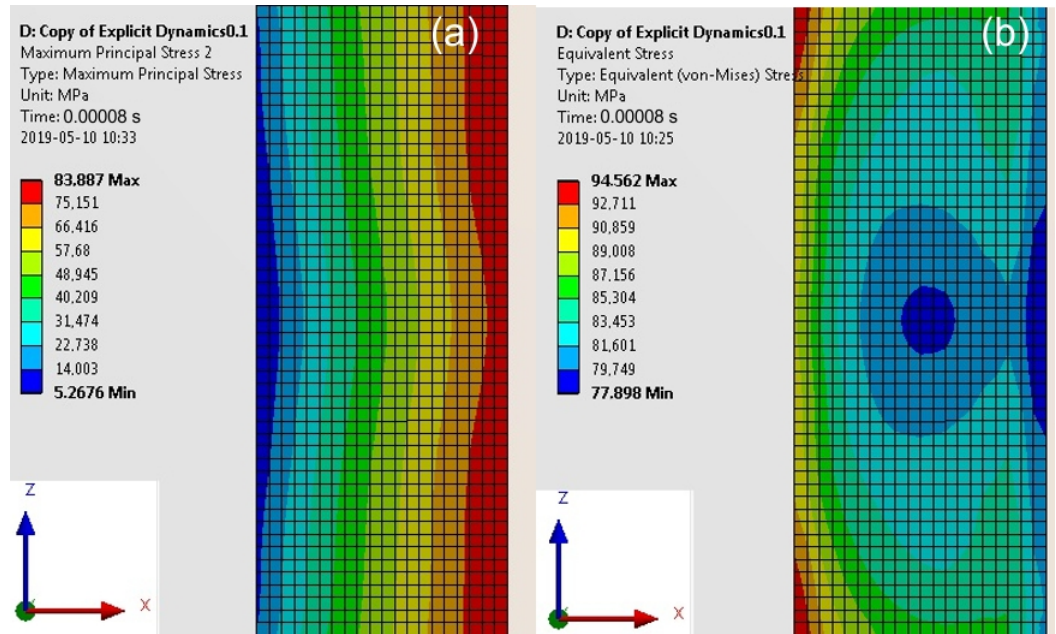
Figure 11. Map of the Main Principal Stress ( a ) and the von Mises Stress ( b ) in the adhesive layer for a computation time equal to 0.00008 s—Model no. 1 (linear analysis). The loads are applied in the direction of the X axis.